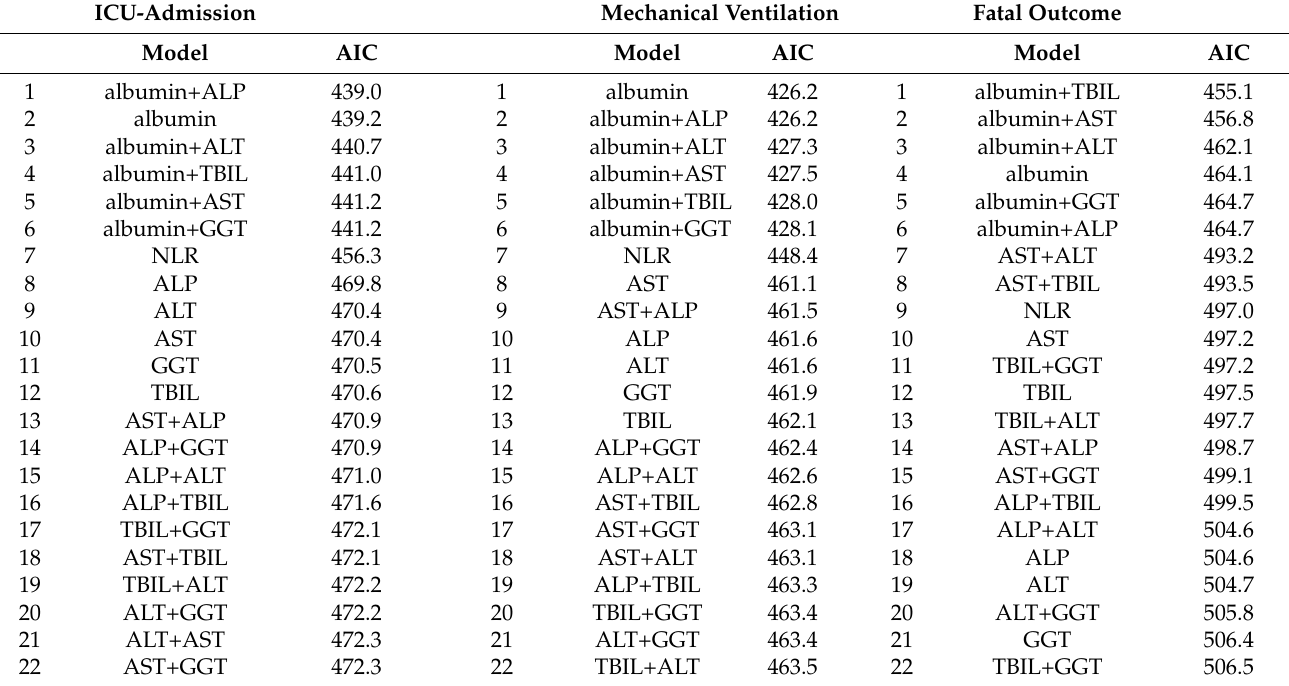
Table 4. Comparison of the models with single parameters and their double combinations adjusted for comorbidities and potential risk factors according to AIC for individual